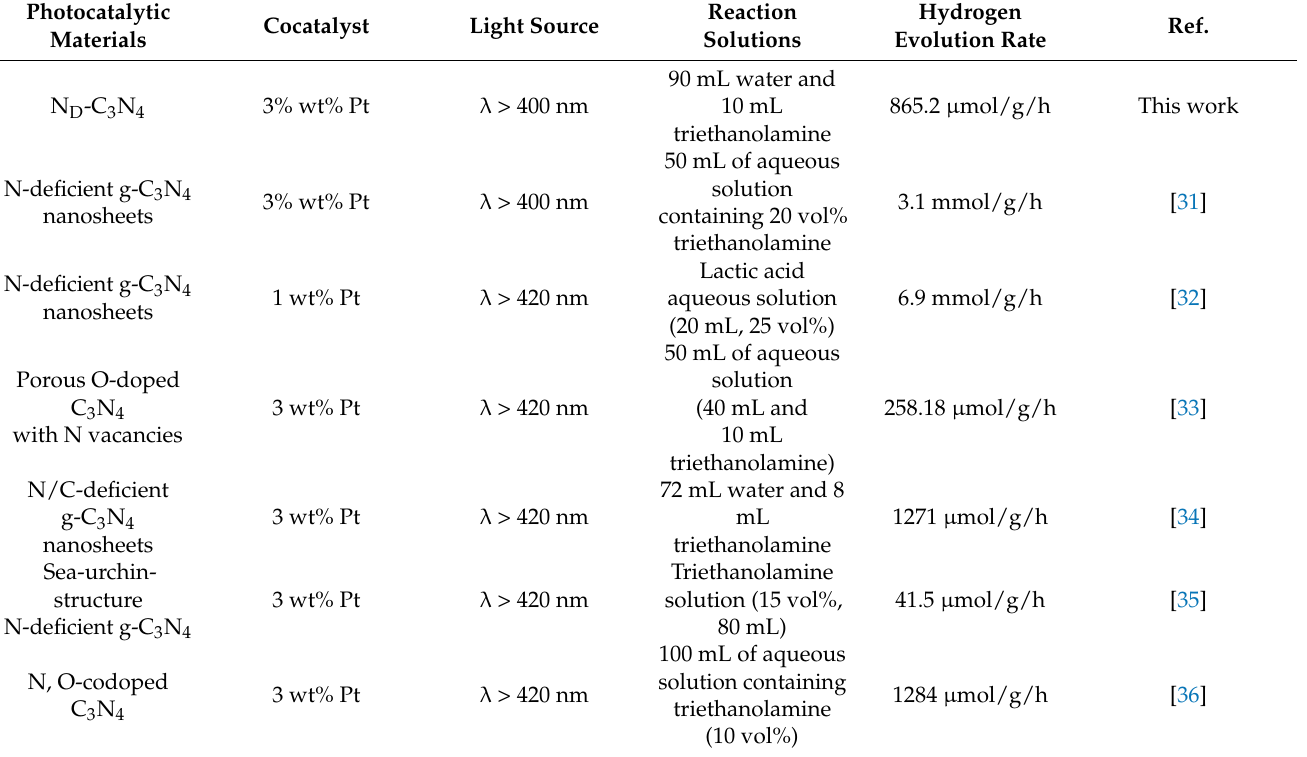
Figure 8. ( A ) The amount of H 2 evolution and ( B ) H 2 evolution rate of the samples, and ( C ) Stability of N D -g-C 3 N 4 in 16 h photocatalytic reaction. Table 2. Comparison of photocatalytic activity with other N-deficient g-C 3 N 4 reported in the literature.